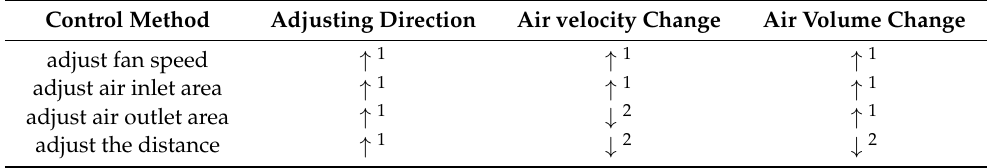
Table 3. Control methods and their